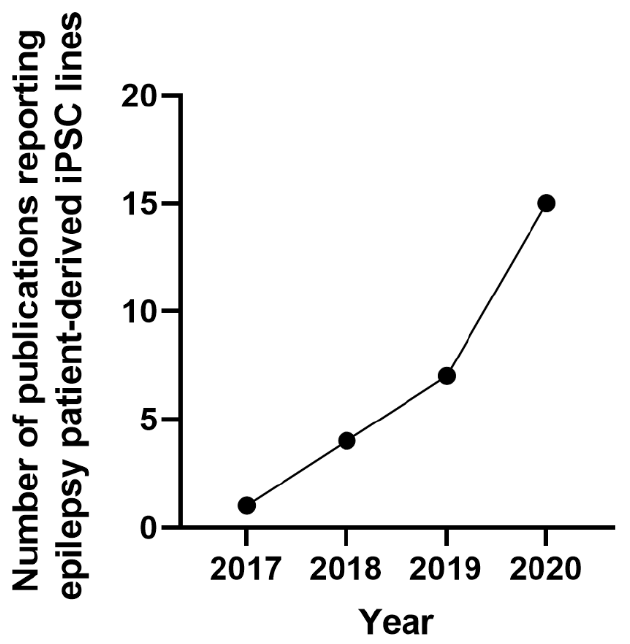
Figure 3. Generation of epileptic patient-specific iPSC lines. The graph indicates the increase in the number of publications reported from 2017 to 2020 that generated iPSC lines from patients with epilepsy.